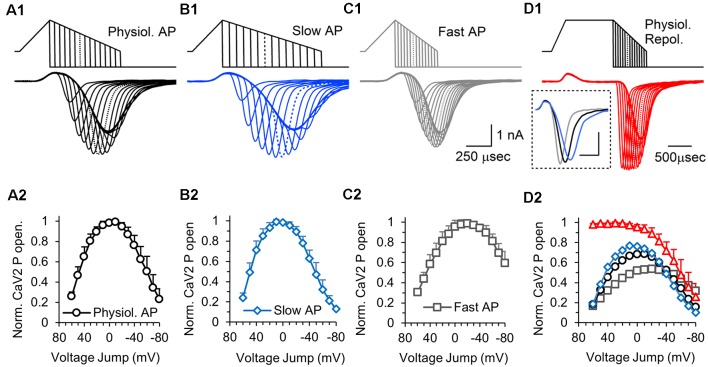
Effects of action potential repolarization duration on the number of presynaptic calcium channels that are activated at different times during the action potential. (A1) The top traces show a series of hyperpolarizing voltage-jumps, 15 in total, that were delivered at different times during the repolarization phase of a physiological AP-like stimulation. The bottom trace shows the overlaid presynaptic calcium channel responses to each voltage-jump. The peak amplitude measures the relative number of calcium channels that are active at each point during the repolarization. Dotted lines in the stimulus and response traces indicate the maximum response. Panels (A1–D1) show representative traces recorded from a single cell. (A2) Graph of the CaV2 open probability for a physiological AP stimulus, measured by the average CaV2 peak response to each voltage-jump, normalized to the maximum response for each cell. Panels (A2–D2), n = 6 cells, with all 60 stimuli tested in each cell. The data points are the average of the normalized responses from each cell. (B1) Responses to hyperpolarizing voltage-jumps during an AP-like stimulation with a slow repolarization phase. (B2) Graph of the CaV2 open probability for a slow AP-like stimulus, measured by the average CaV2 peak response to each voltage-jump during, normalized to the maximum response (at +10 mV). (C1) Responses to hyperpolarizing voltage-jumps during an AP-like stimulation with a fast repolarization phase. (C2) Graph of the CaV2 open probability for a fast AP-like stimulus, measured by the average CaV2 peak response to each voltage-jump, normalized to the maximum response (at −20 mV). Inset shows (D1). Prolonged depolarization to open all available presynaptic calcium channels followed by a series of hyperpolarizing voltage-jumps during an AP-like repolarization phase. Inset shows the full response to AP-like stimulation without a voltage jump for a normal (black), fast (blue) or slow (gray) repolarization (scale bar: 0.5 ms, 1 nA). (D2) Graph of the average CaV2 open probability for all four stimuli tested normalized to the responses to the long depolarization (D1) stimulus which should produce the maximum CaV2 open probability: long-depolarization (red triangles); physiological repolarization (black circles); slow repolarization (blue diamonds); fast repolarization (gray squares). The responses to each stimulus are normalized to the long depolarization maximum response for each cell, and the normalized data from each cell were averaged (red triangles).